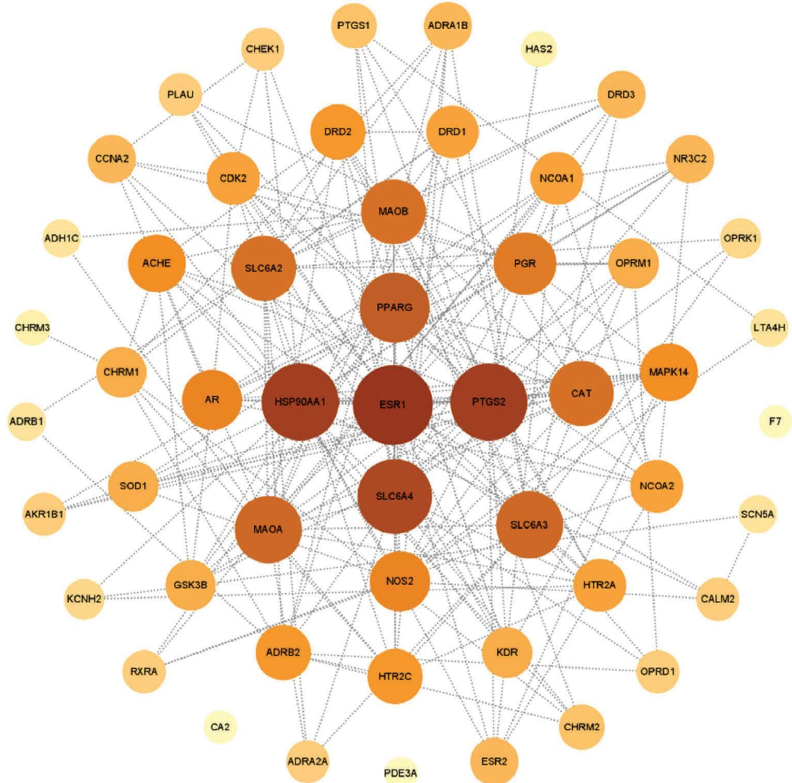
Figure 3: Bitter almond antioxidant intersectional target interaction